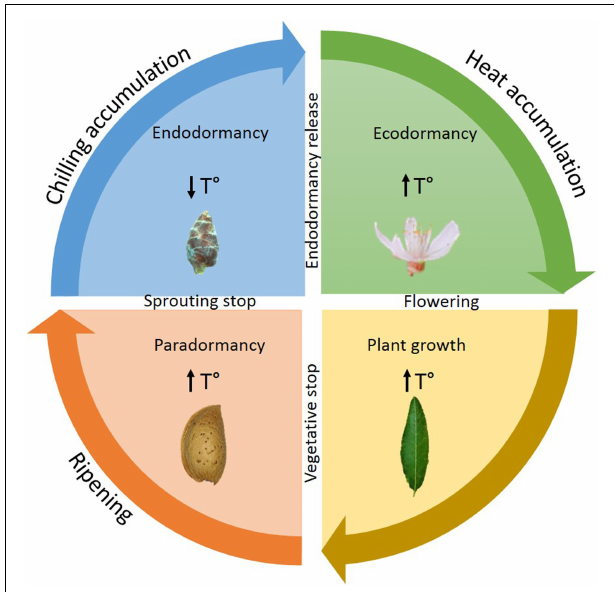
FIGURE 1 | Dormancy cycle and plant growth. Events that take place in the different stages of dormancy cycle and plant